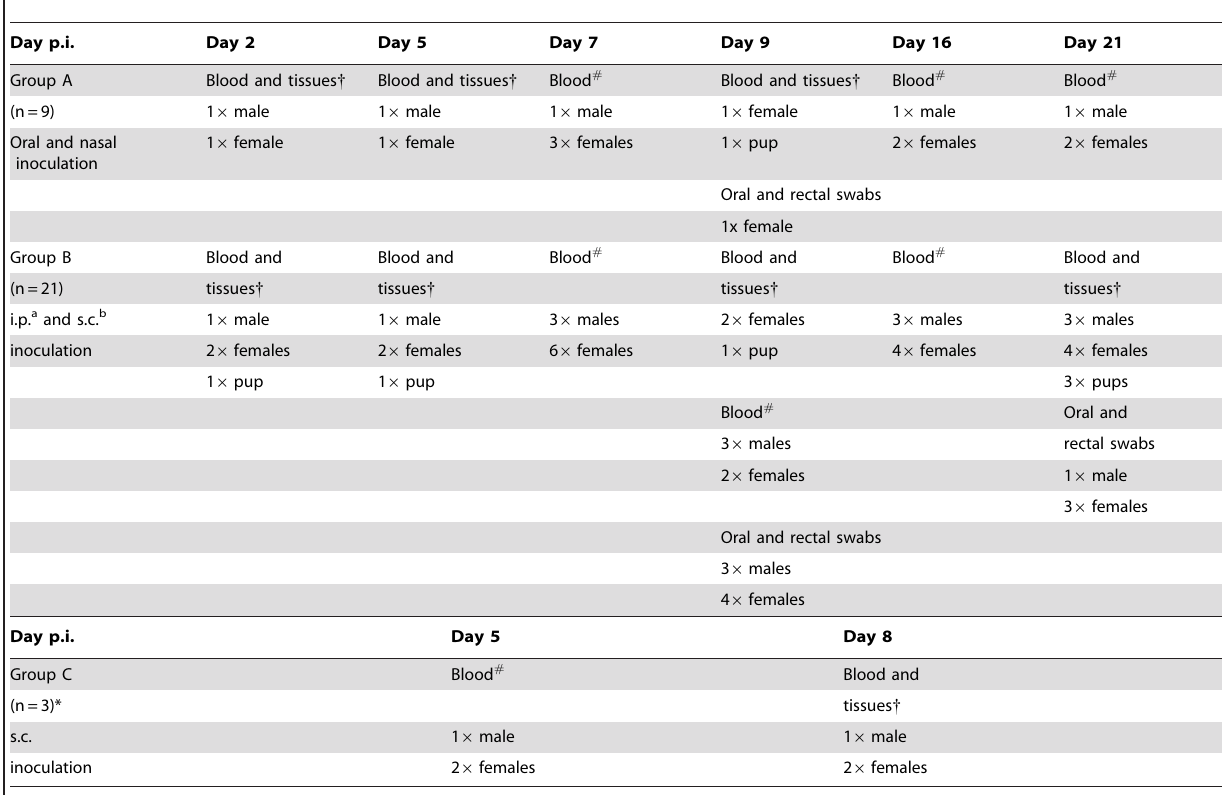
Table 1. Experimental design and sample collection schedule in R. aegyptiacus bats inoculated with Hogan strain of MARV.